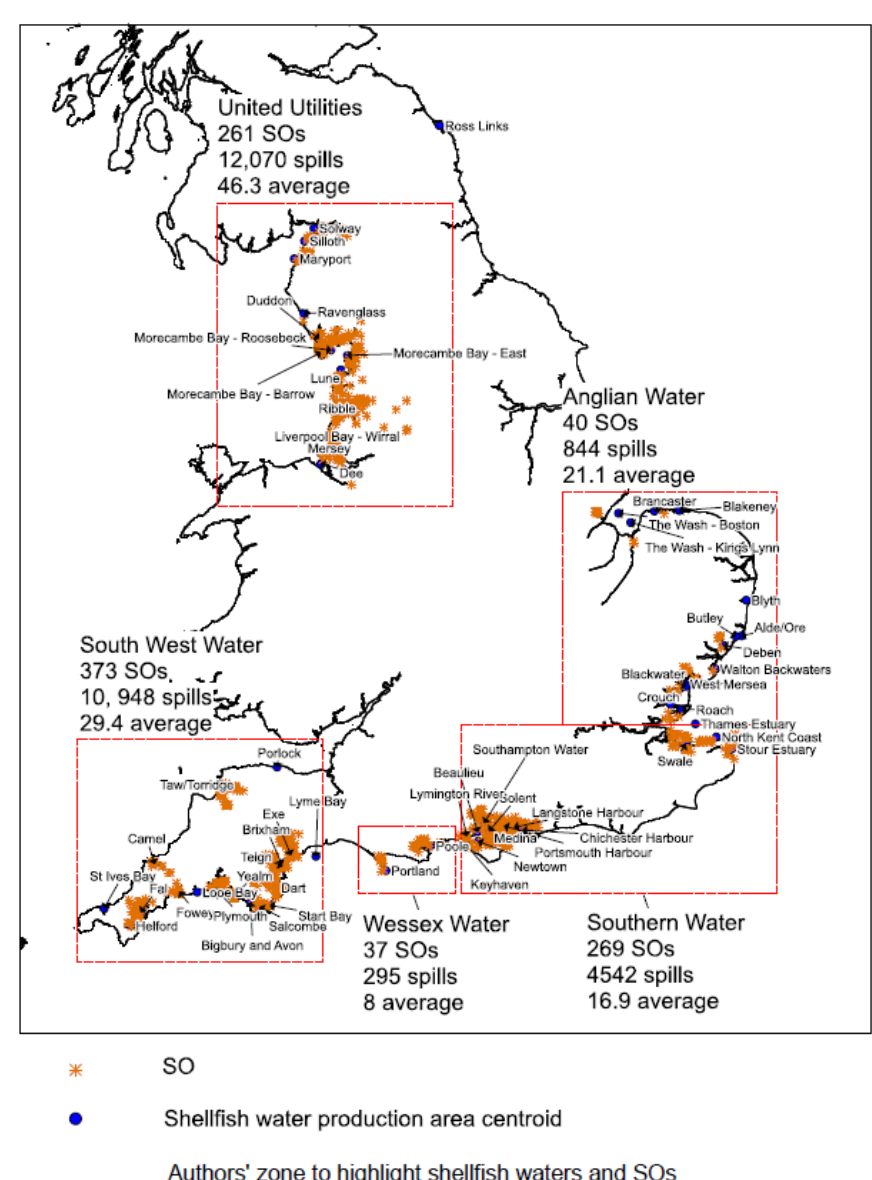
Figure 4. Permitted SO discharges in England with a shellfish waters-associated spill reporting requirement and classified bivalve shellfish production areas. Average figures represent the number of spills per SO by